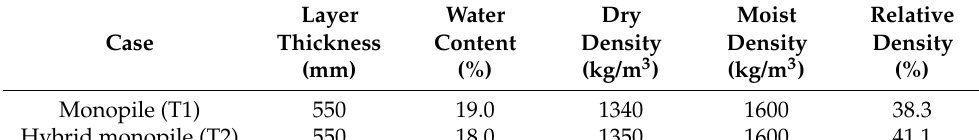
Table 3. Fundamental properties of soil foundation for conventional and hybrid monopiles.